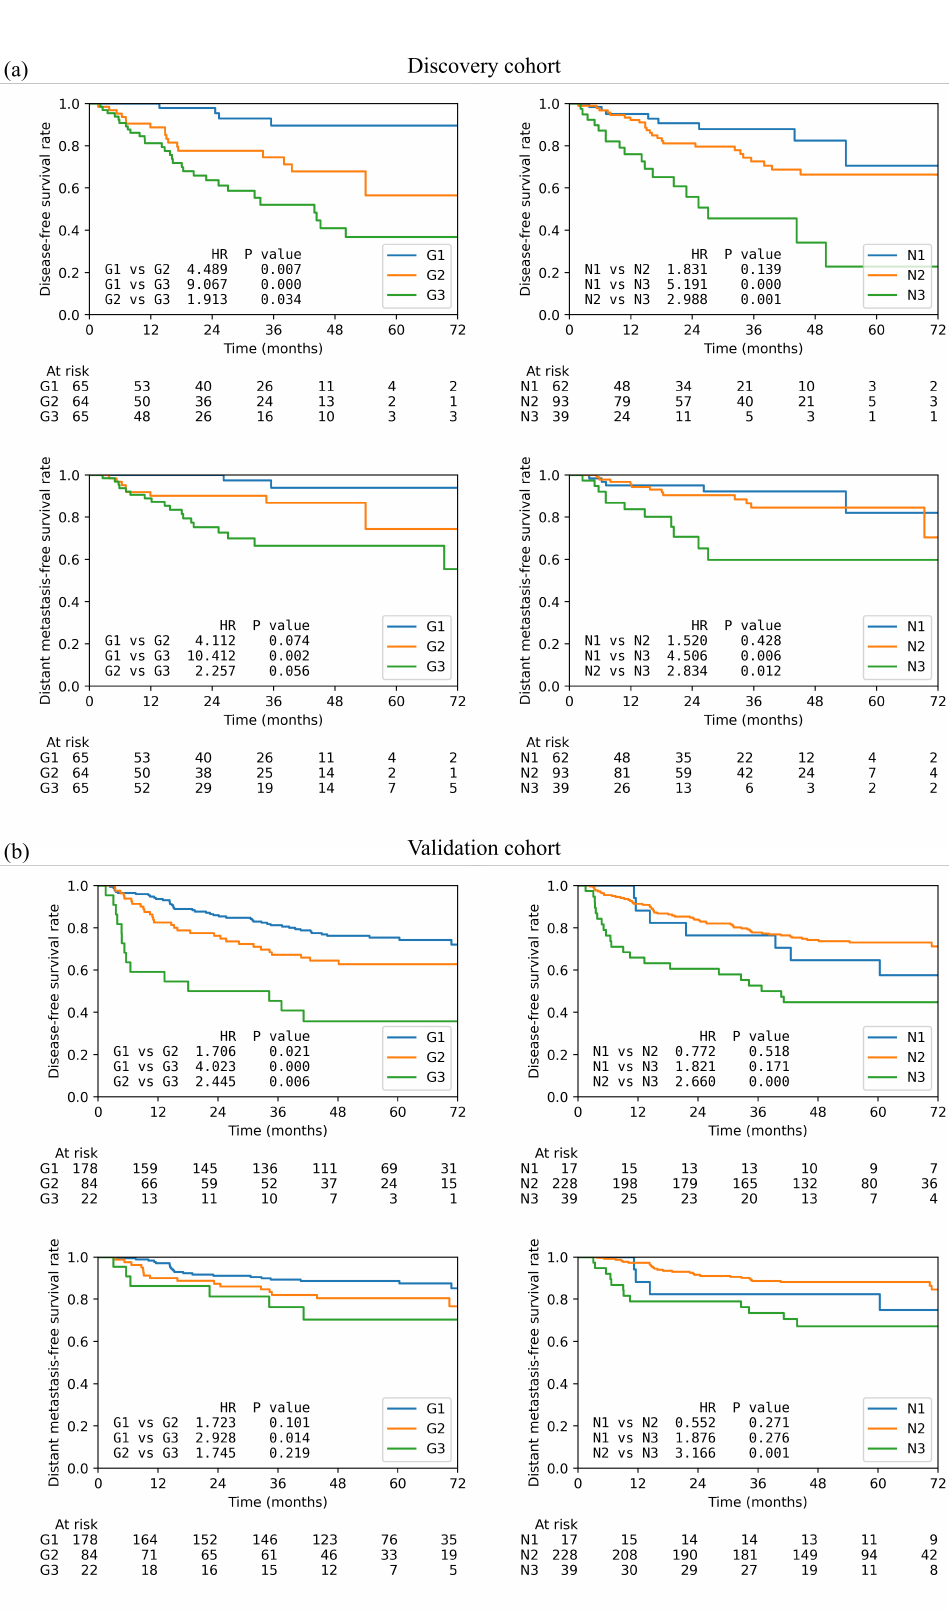
Figure 3. Kaplan–Meier curves of the low-(G1), median-(G2), and high-risk (G3) patient groups based on the new spatial index and the three N stages on ( a ) disease-free survival and ( b ) distant metastasis-free survival. Each plot also contains the hazard ratio (HR) and the corresponding p -value between each two